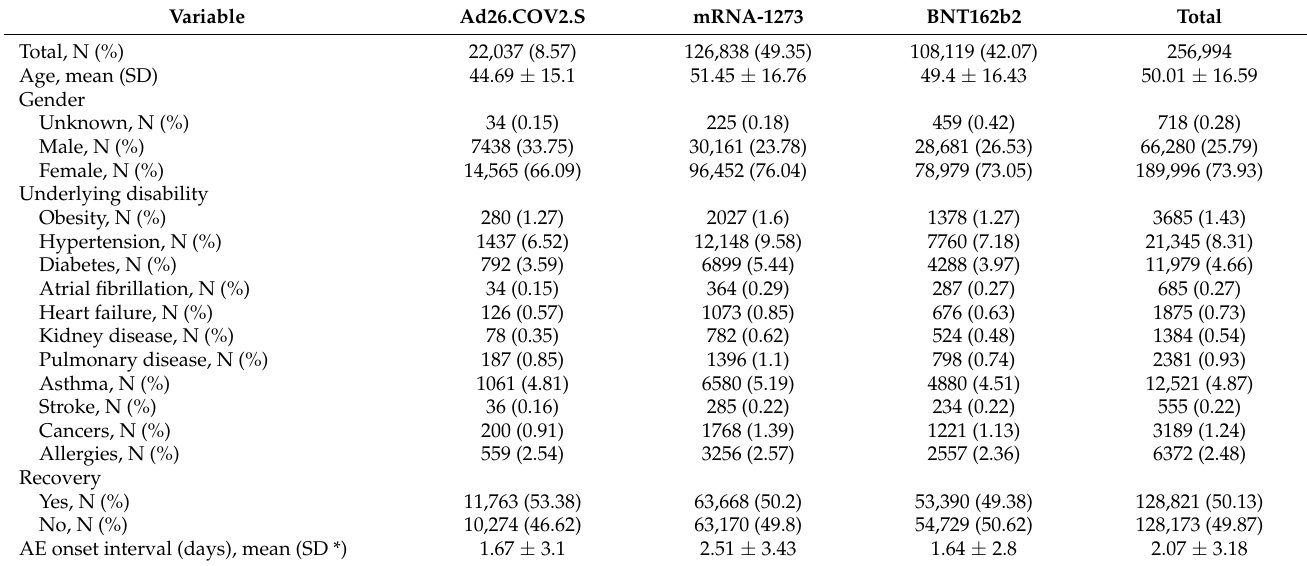
Table 1. Demographic and clinical characteristics of all individuals vaccinated against